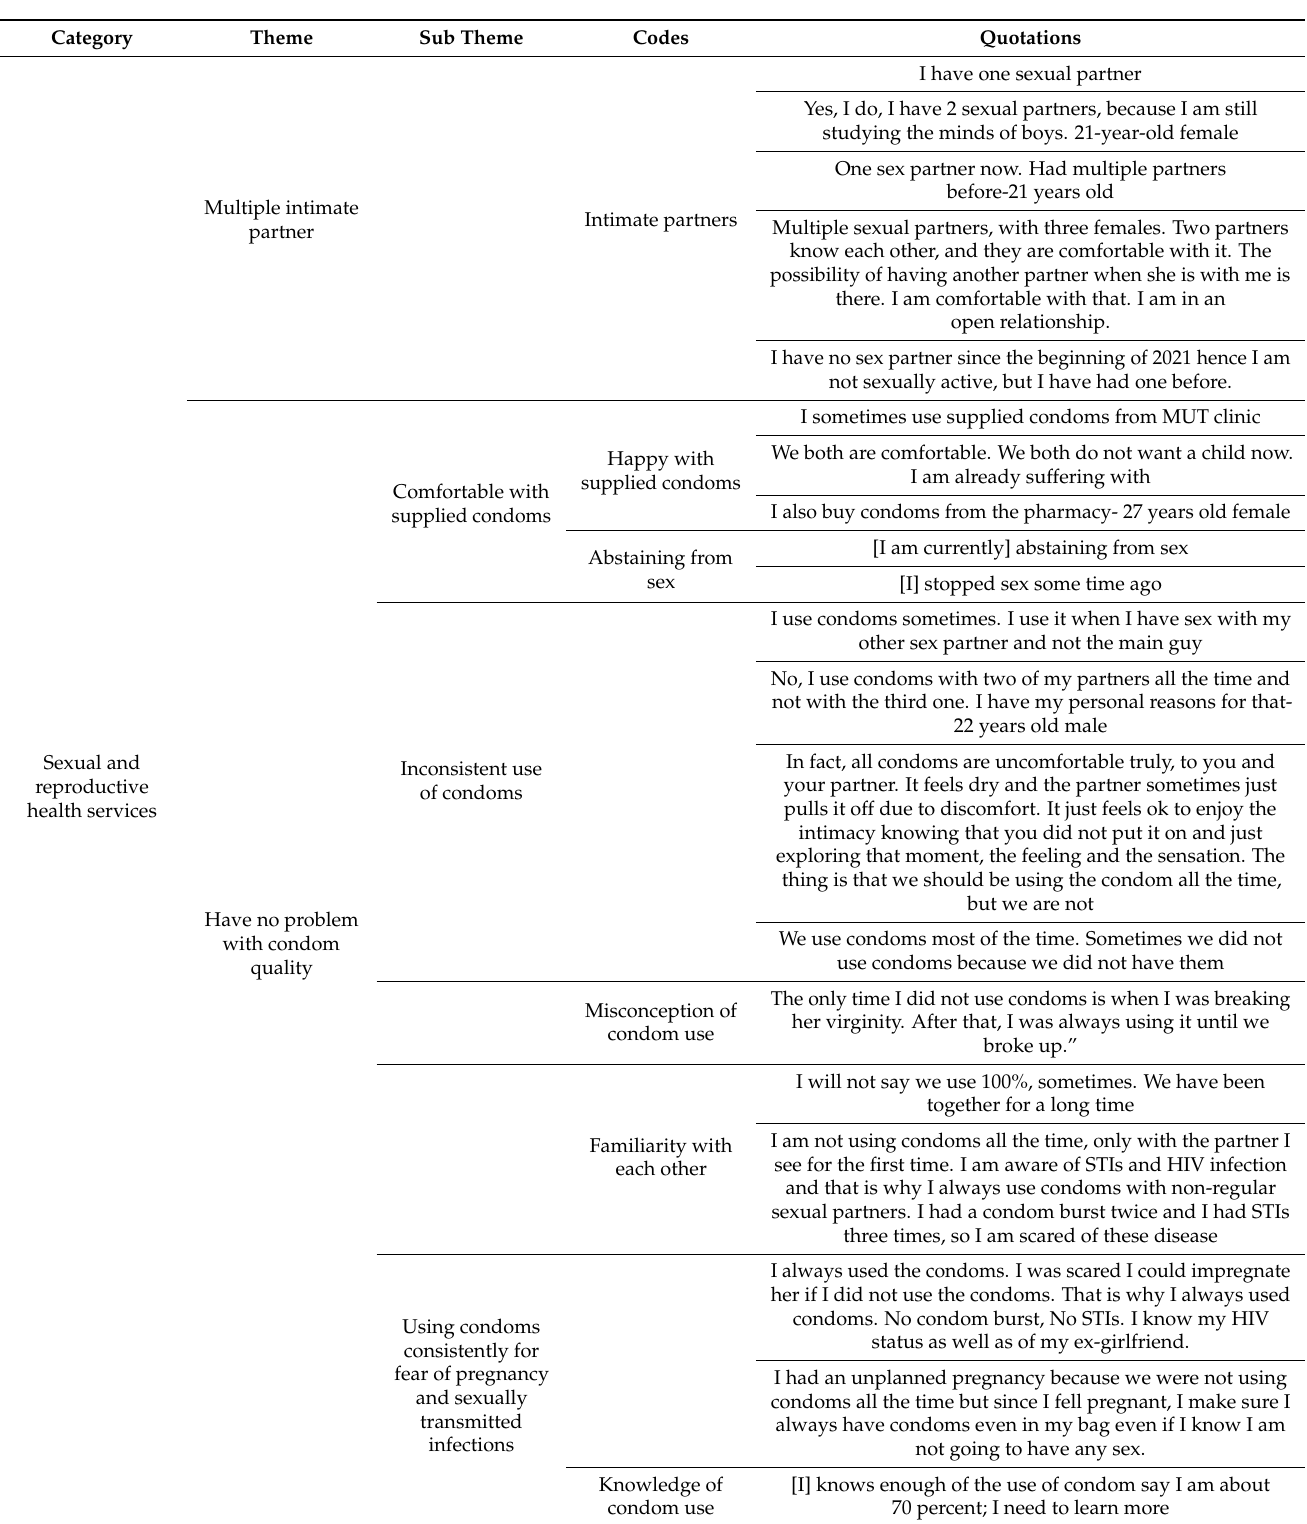
Table 1. Themes, subthemes, and codes inductively extracted from the